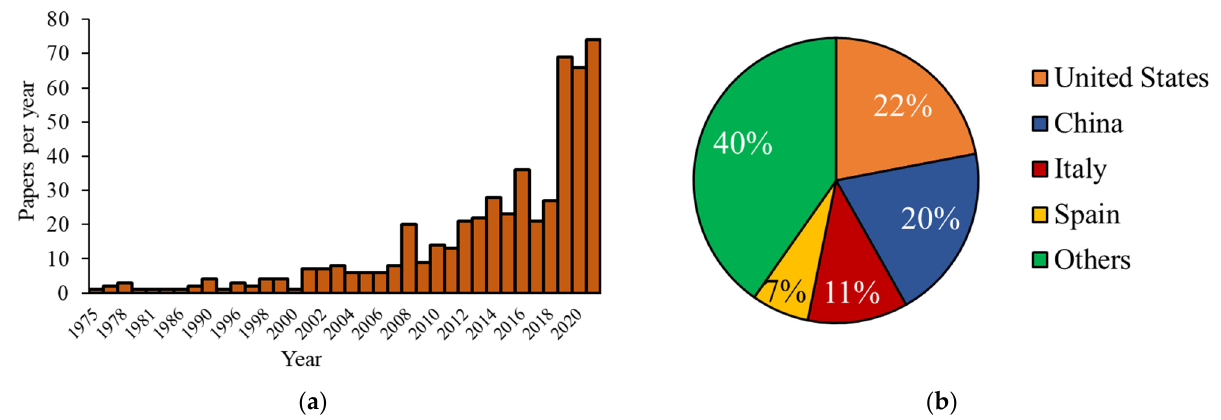
Figure 1. ( a ) Number of papers and ( b ) distribution by country of papers published from 1975 to 2021 on biodegradable mulches. Source: Scopus ® .